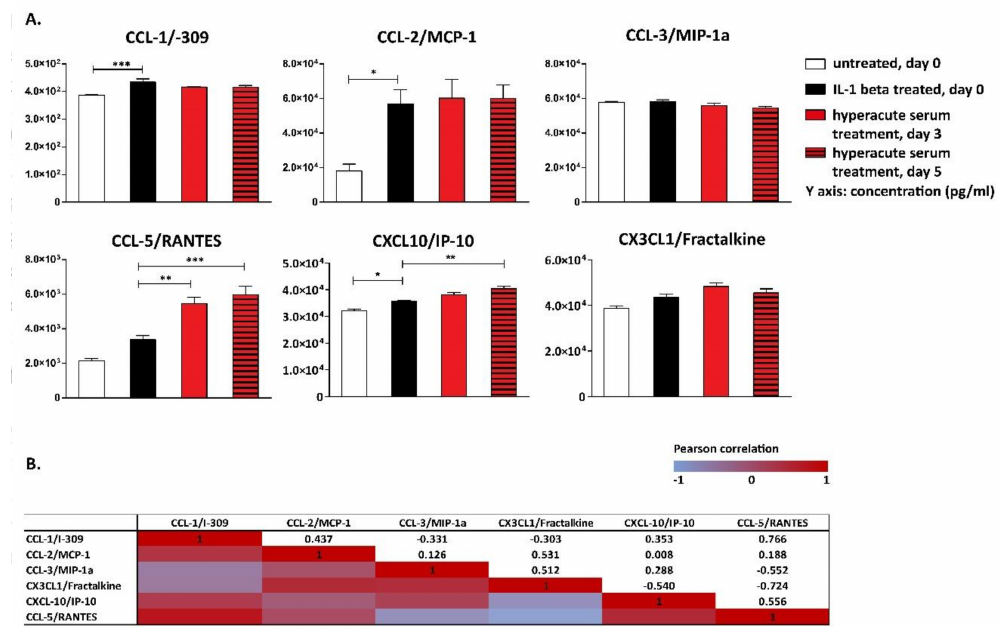
Figure 6. Inflammatory chemokines detected in the tissue culture supernatant. Chemokine CC ligand 1 (CCL-1), CCL-2, and chemokine C-X-C ligand 1 (CXCL-10) increased significantly after IL-1 β stimulation, and the level of CCL-5 and CXCL-10 increased even further in response to hyperacute serum, n = 12. The significance level was p < 0.05, where * means that the p -value was between 0.05 and 0.01, ** means that the p -value was between 0.01 and 0.001, and *** means that the p -value was lower than 0.001 ( A ). The correlations of chemokine changes are presented in heatmap tables. Between day 0 and day 5, strong correlations were present between CCL-5 and CCL-1, factalkine and CCL-2, CCL-3, CCL-5, and CXCL-10, while strong reverse correlations were found between CXCL-10 and fractalkine, CCL-5 and CCL-3, and fractalkine and CCL-5, n = 12 ( B ).